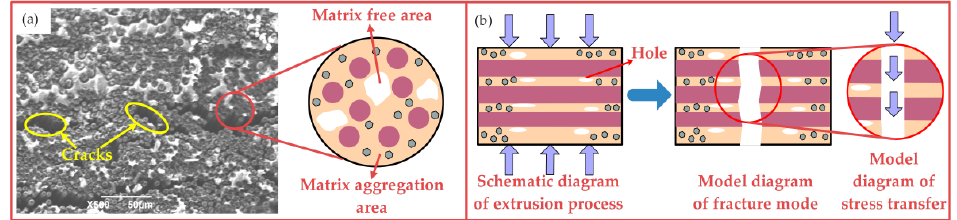
Figure 11. Fracture microstructure and mechanism of GO-CF/EP composite (70 °C): ( a ) fracture microstructure, ( b ) fracture mechanism.